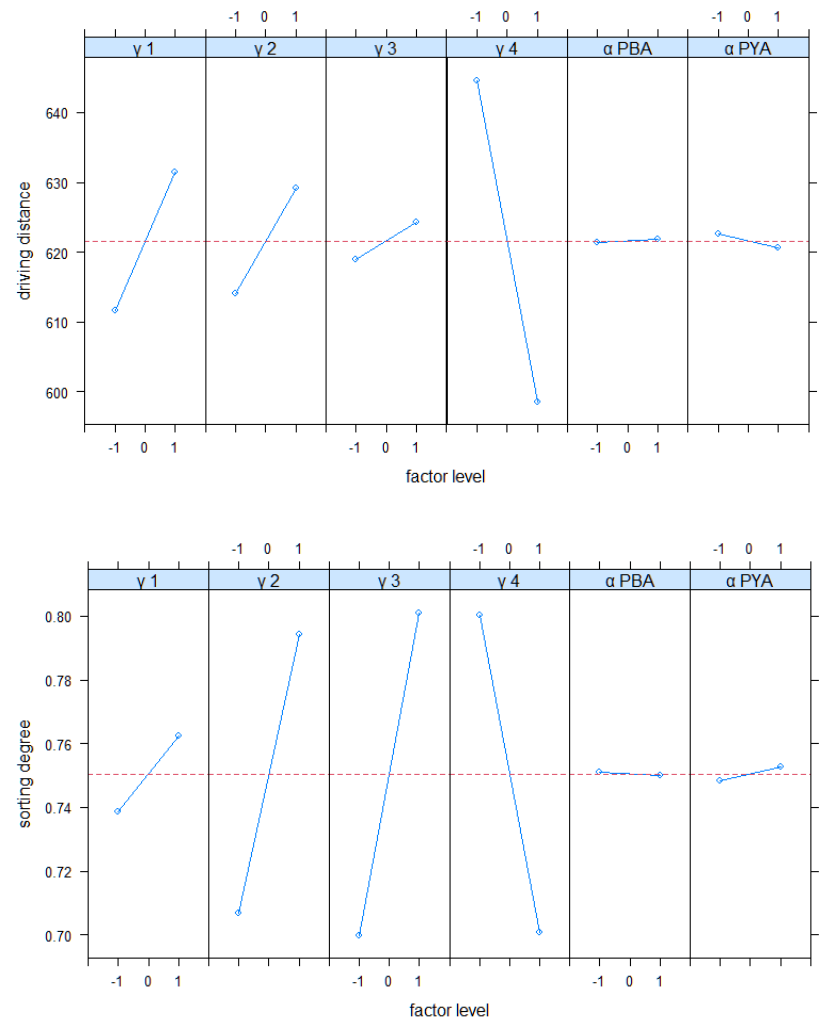
Figure 8. Main effects of FFD study in the generic scenario.